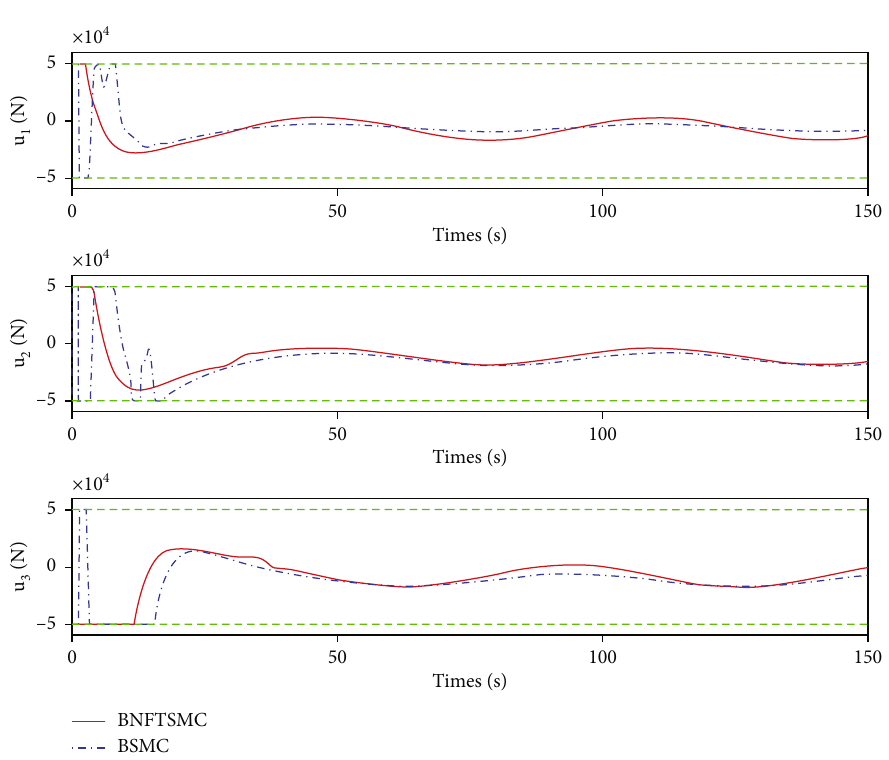
Figure 11: Angular velocity tracking responses.